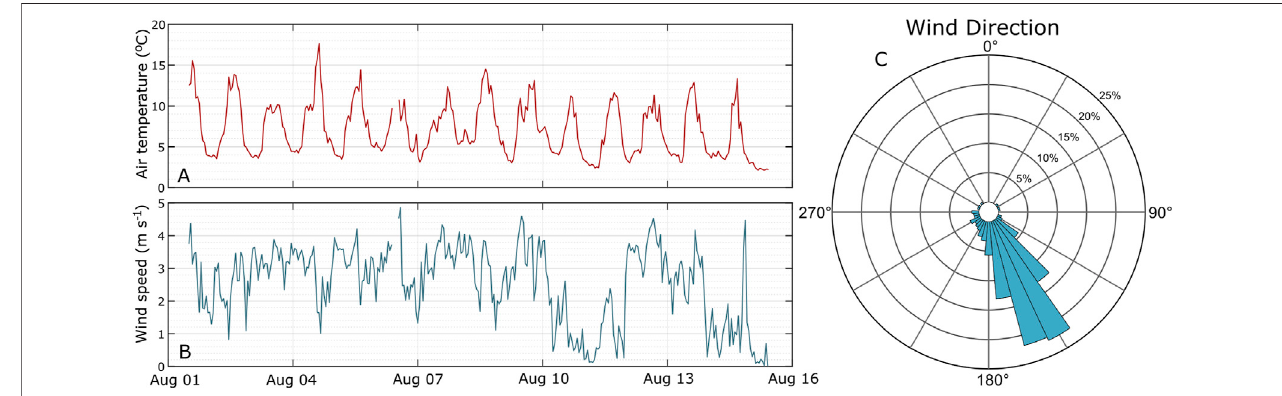
FIGURE 3 | Meteorological data collected during study period. Both air temperature (A) and wind speed (B) are shown as hourly averages at ∼ 1 m above the glacier surface. A short gap in data on 6th August was caused by a hardware fault. Wind direction (C) is also hourly average with 0 ° set to the down glacier direction. All data are for Plot